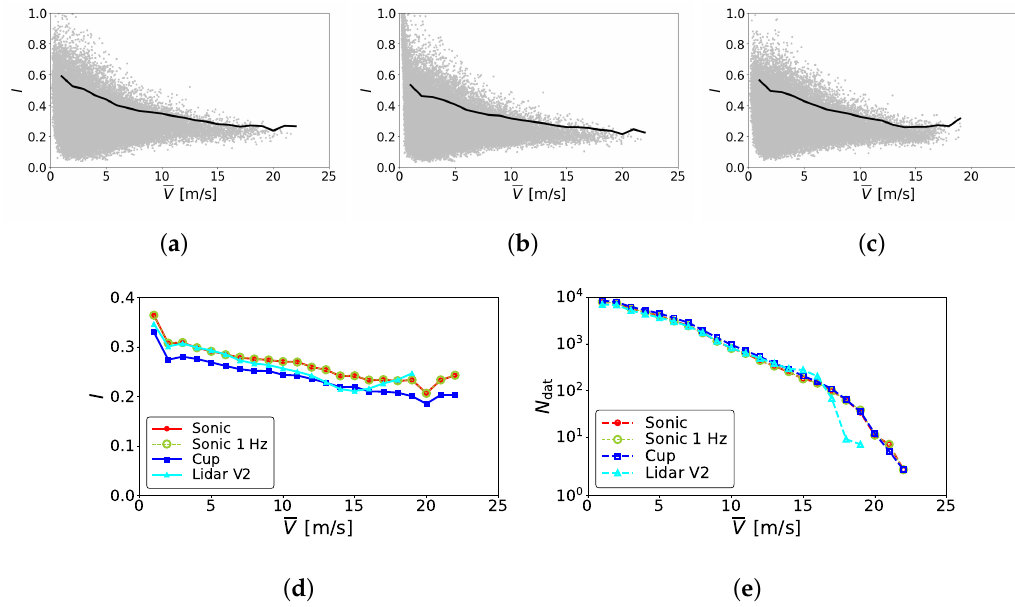
Figure 7. Turbulence intensity as a function of mean wind speed at 40 m height. ( a ) Sonic anemometer; ( b ) Cup anemometer; ( c ) V2 profiling LiDAR; ( d ) Bin-averaged turbulence intensities; ( e ) Number of 10-min average data per bin. Lines in ( a – c ) represent the 90th percentile of the standard deviation for the wind speed bin. Bin size is set to 1 m/s of mean wind speed.